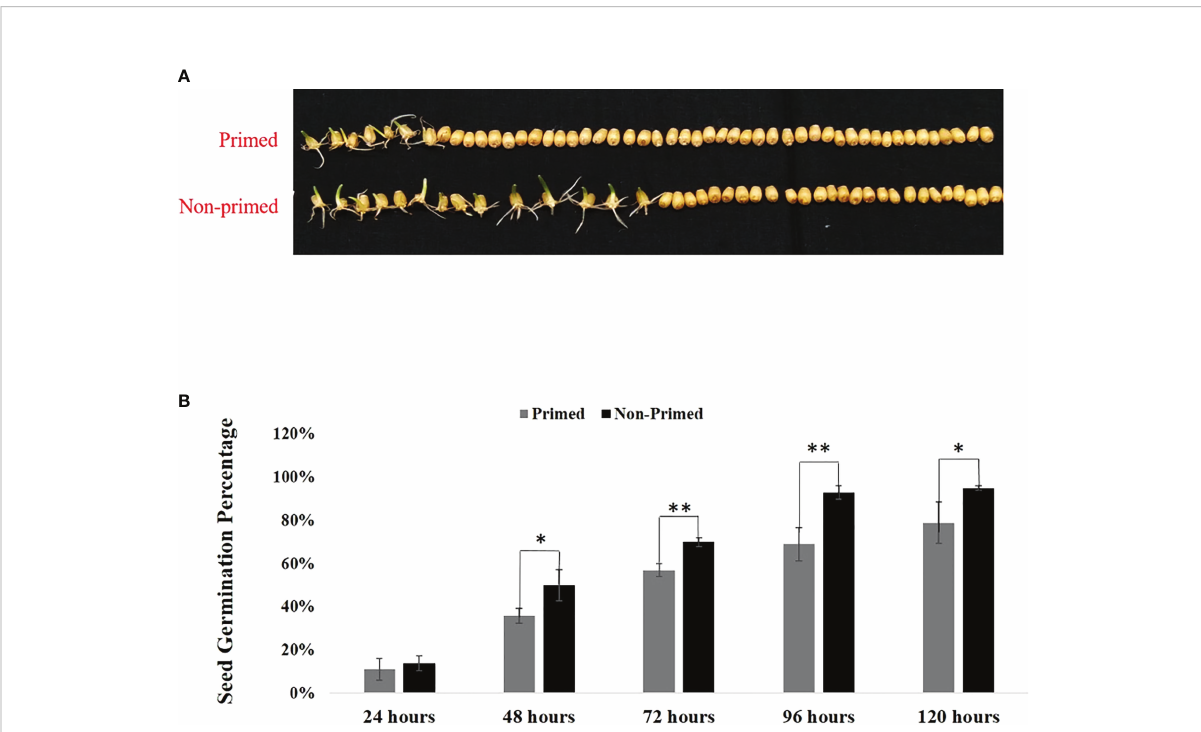
FIGURE 1 Germination of Trichoderma primed and non-primed wheat seeds in parent (G0) generation. (A) Germination of Trichoderma primed and non-primed wheat seeds after 48 hrs. (B) Seed germination percentage of primed and non-primed wheat seeds after 120 hrs. (11 — 50). Data in (B) is represented as mean ± SD, and P values (*P< 0.05 and **P< 0.01) are indicated by student's-t test. Results are representatives of three independent biological replicates.